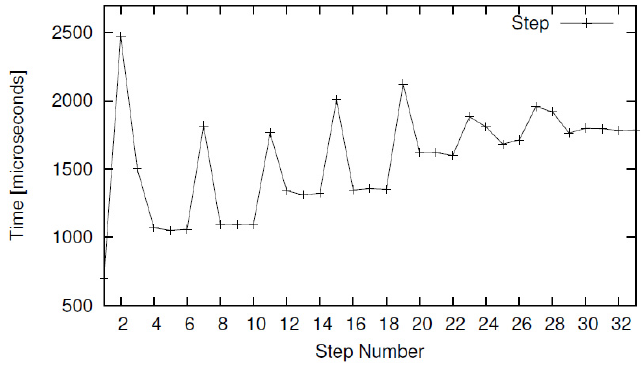
Fig. 8. Time overhead of simulation